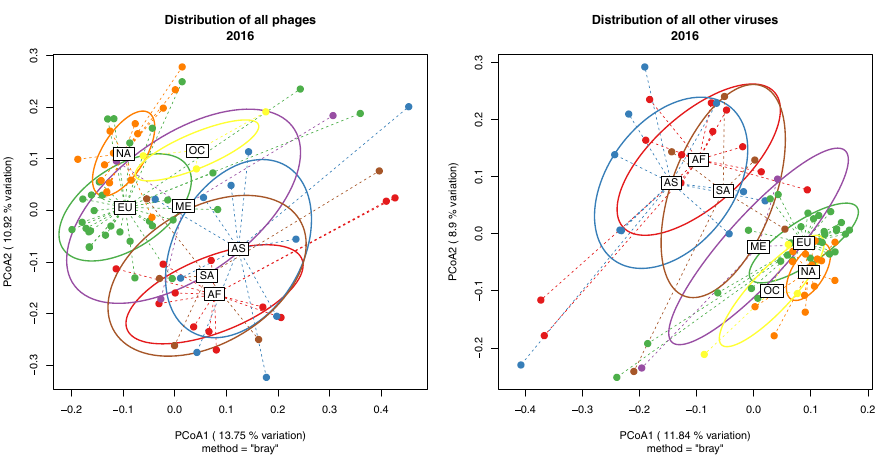
Figure 2. Regional distributions of phages (left) and other viruses (right) from all databases. AF Africa, AS Asia, EU Europe, NA North America, ME Middle East, OC Oceania, SA South America.